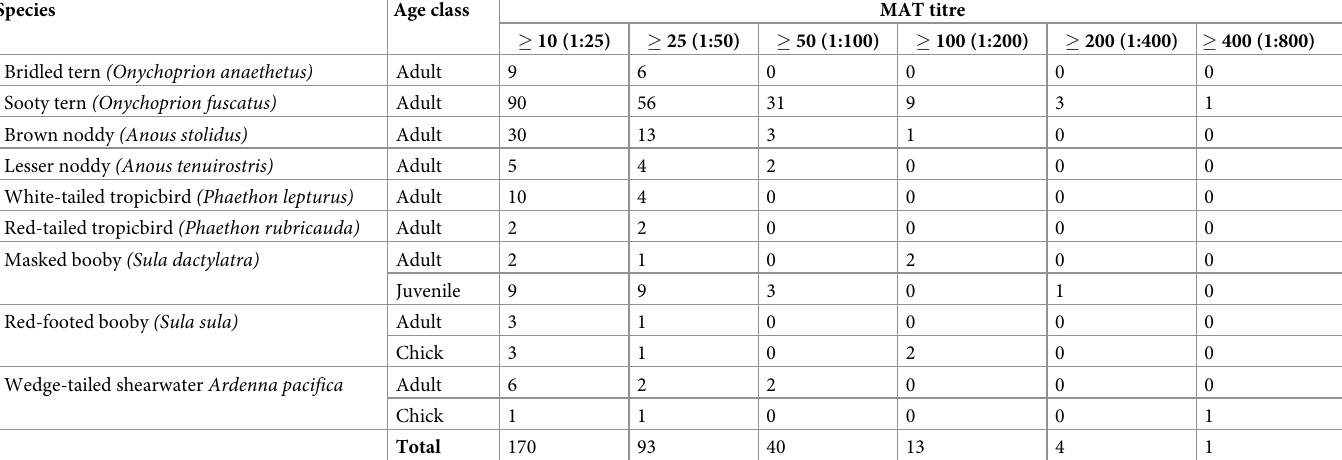
Table 2. Number of samples tested positive for Toxoplasma gondii antibodies per species, age-class and titre of the Modified Agglutination Test (MAT). In brackets: corresponding dilution. Species Age class